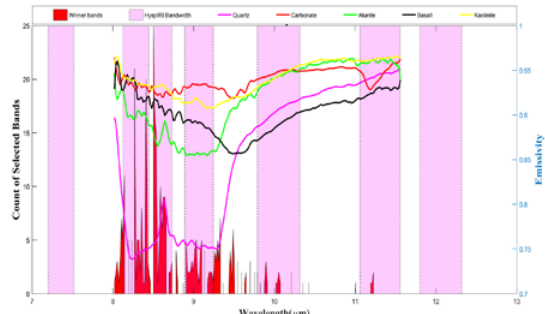
Figure 4. The count of selected (winner genes) bands after 40